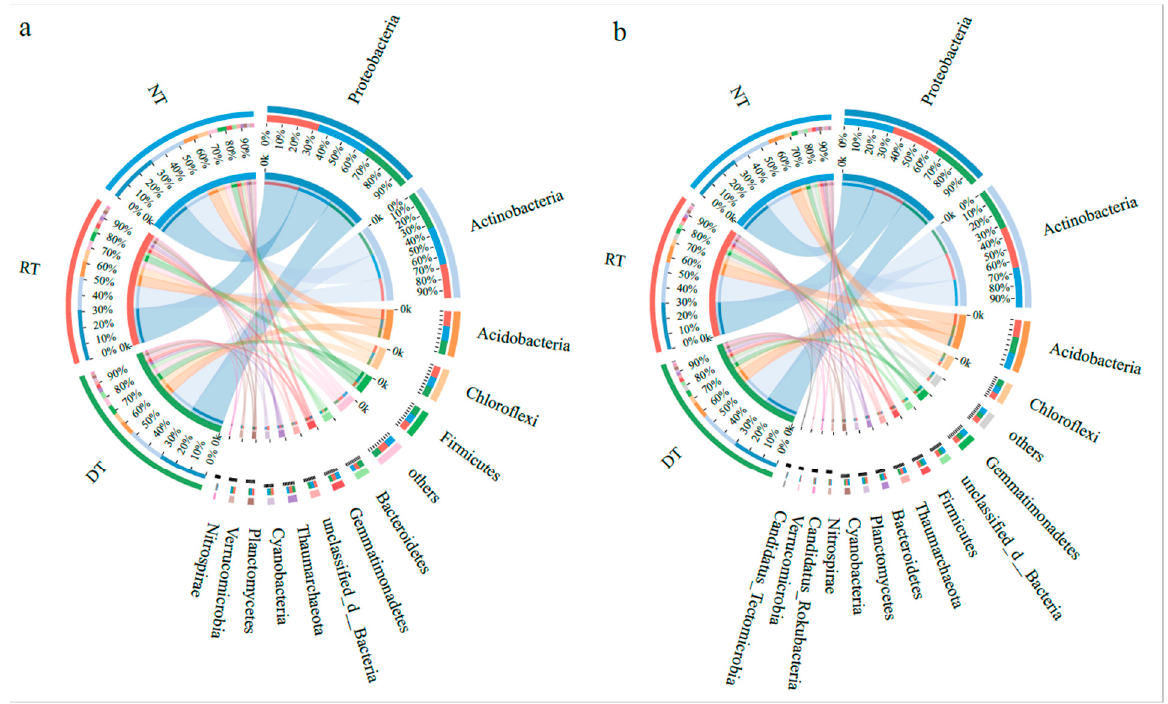
Figure 1. The relative abundance of dominant phyla in the 0 to 20 cm layer with no tillage (NT), rotary tillage (RT), and deep tillage (DT) (the average relative abundance > 1%) during the ( a ) wheat and ( b ) maize seasons. Table 1. The relative abundance of soil bacteria, archaea, and fungi in the different tillage treatments. Index Wheat